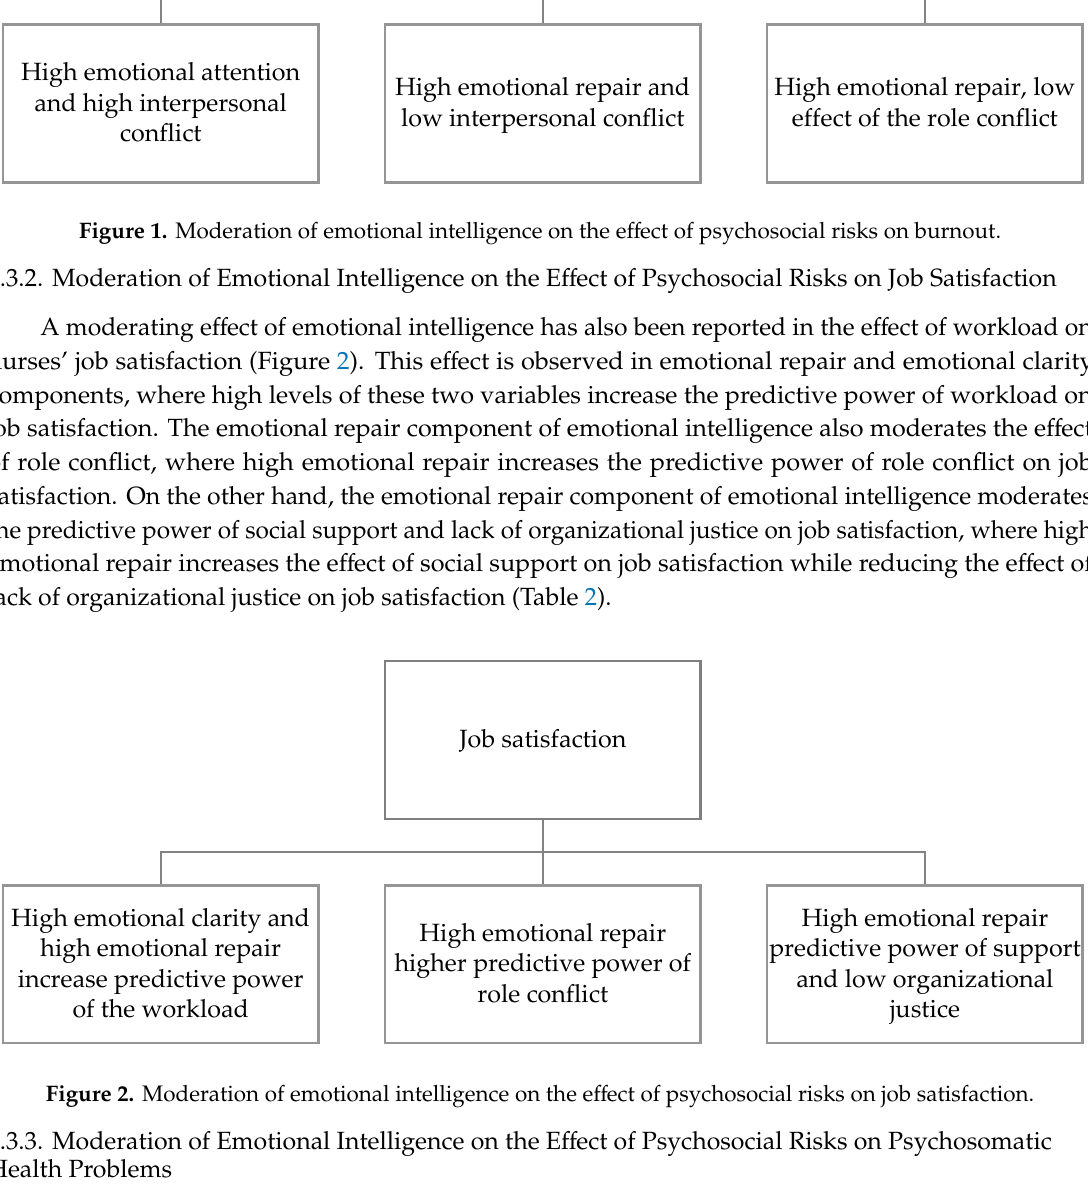
Figure 2. Moderation of emotional intelligence on the effect of psychosocial risks on job satisfaction.